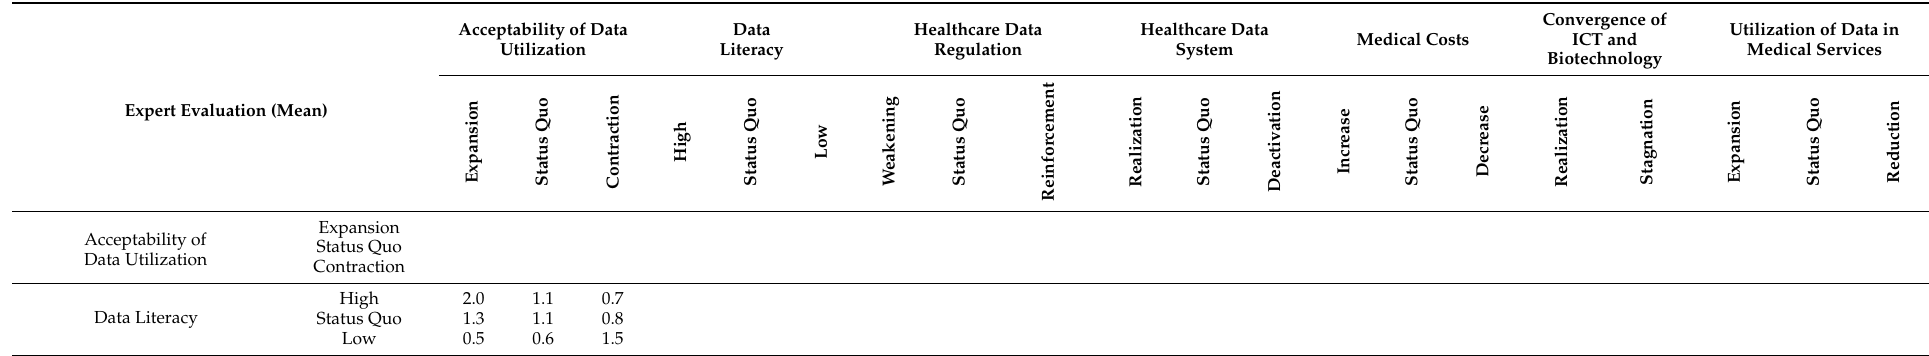
Table 2. Expert evaluation